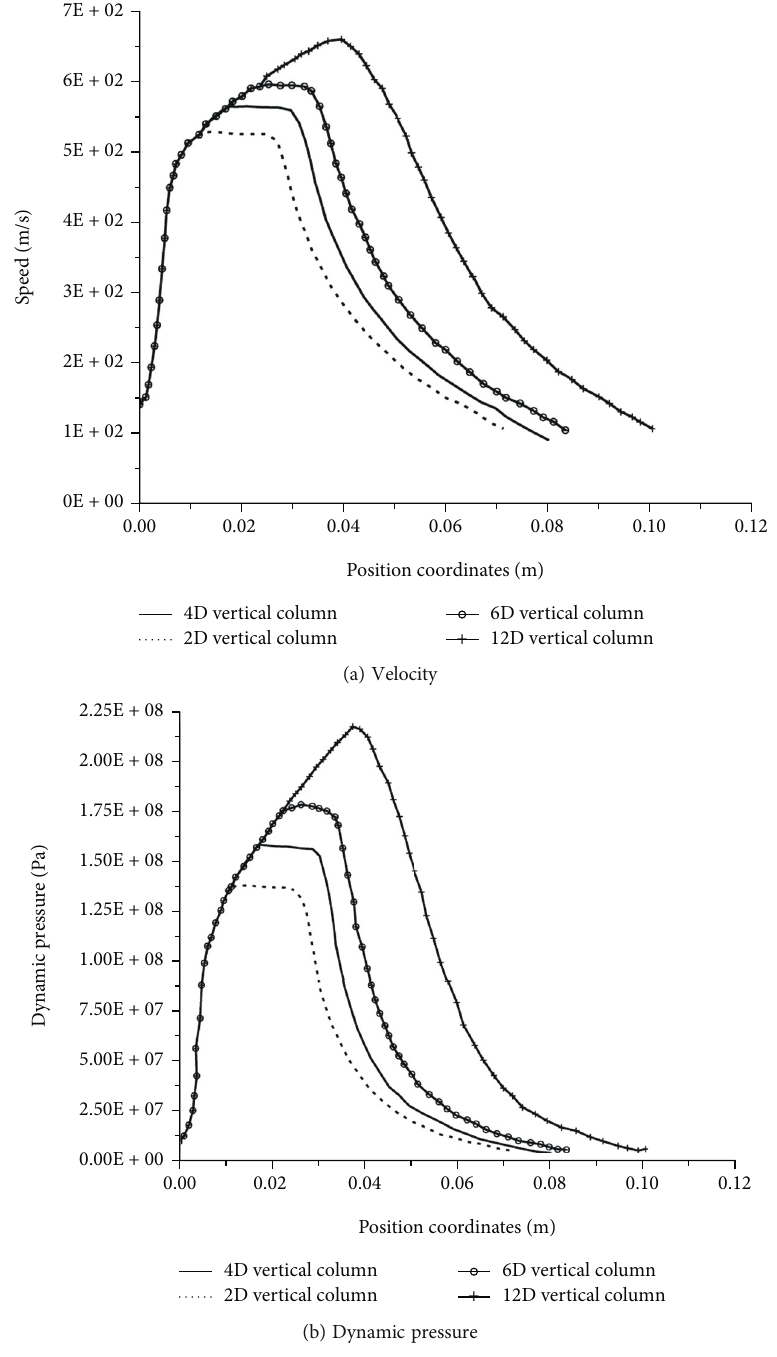
Figure 12: The distribution of the water jet on the central